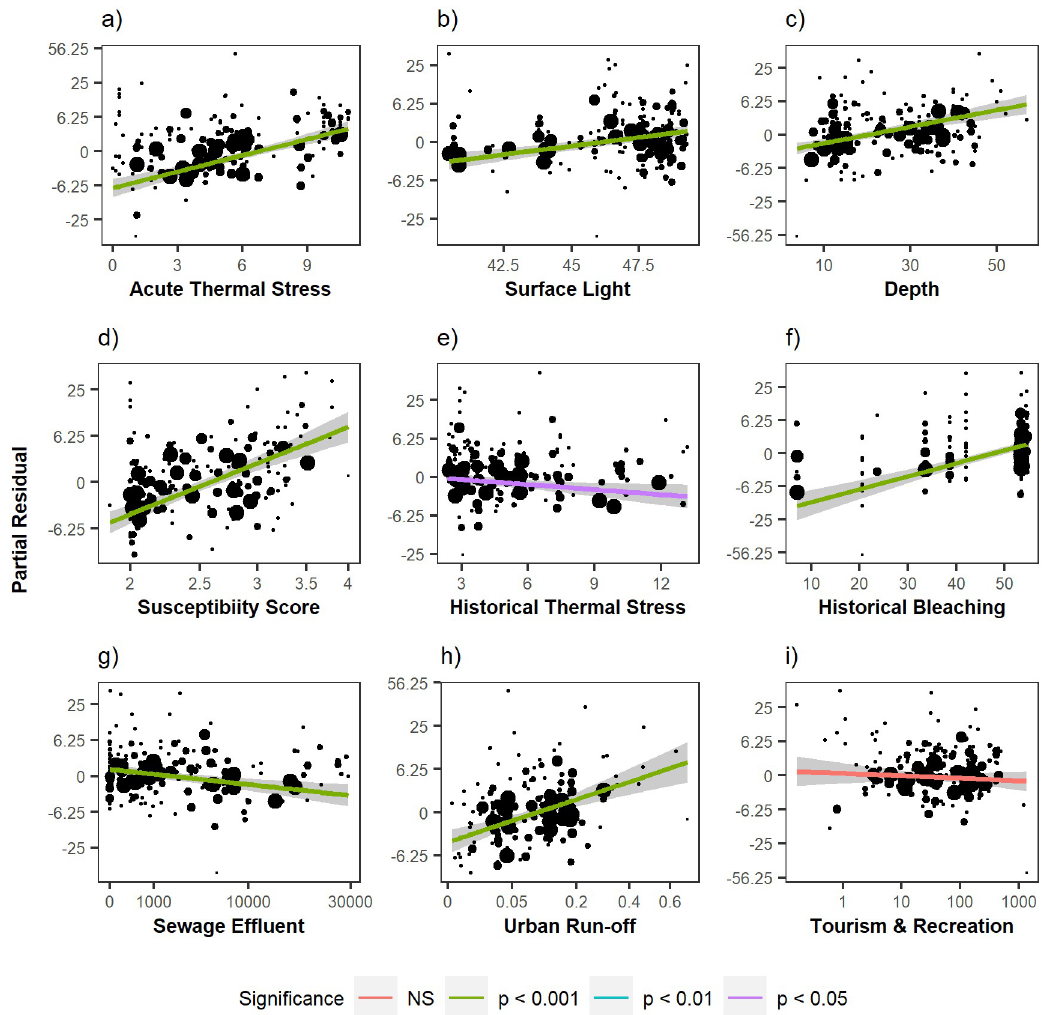
Fig 6. Partial regression plots. Solid line: Back-transformed predicted percent bleached from best-fit model minus the intercept of the reduced model (best-fit model when the variable of interest and all interactions are removed) across range of (a) acute thermal stress (DHW), (b) surface light (PAR), (c) depth (ft), (d) taxonomic susceptibility score, (e) historical thermal stress (DHW), (f) historic percent bleached (%), (g) sewage effluent, (h) urban run-off, and (i) tourism and recreation. Grey area: upper and lower 95% confidence intervals. Points are the back-transformed residuals of the reduced fit model. Residuals are sized by observation weight. See S8 Table for variable